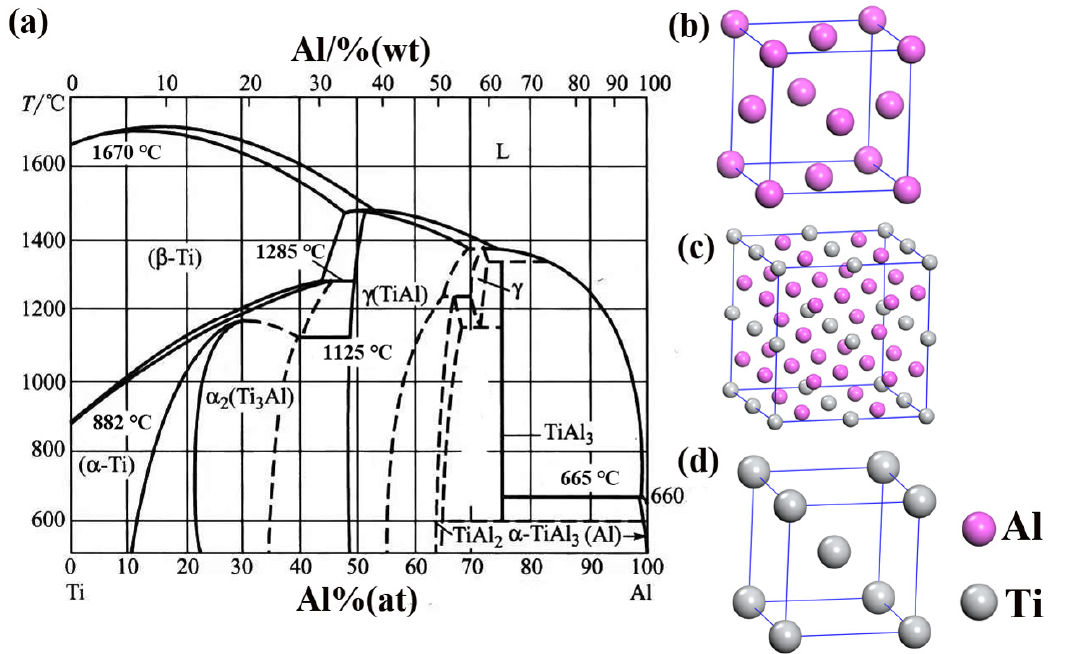
Figure 1. ( a ) The phase diagram of Al–Ti alloys; ( b ) the unit cell of Al FCC bulk; ( c ) the 2 × 2 × 2 supercell of Al 3 Ti intermetallic; ( d ) the unit cell of Ti BCC bulk (high temperature).